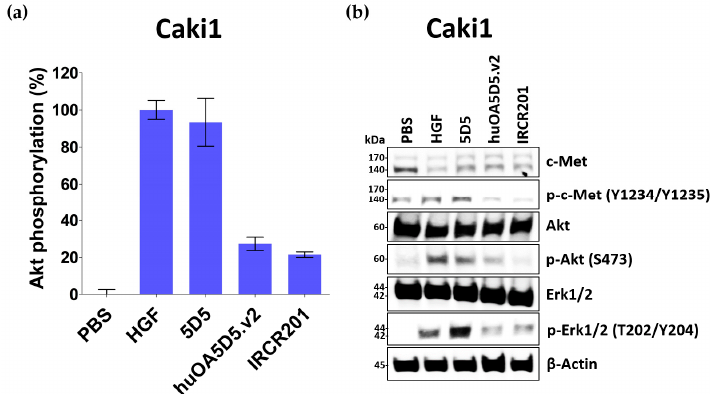
Figure 4. Agonist activity assay. Caki1 cells were starved in serum-free medium for 24 h and incubated with 100 nM of c-Met antibodies or 50 ng/mL of HGF for 30 min. ( a ) Akt phosphorylation in Caki1 cells was measured by ELISA; ( b ) Western blot analysis of c-Met, phospho-c-Met, Akt, phospho-Akt, Erk1/2, phospho-Erk1/2, and β -actin.